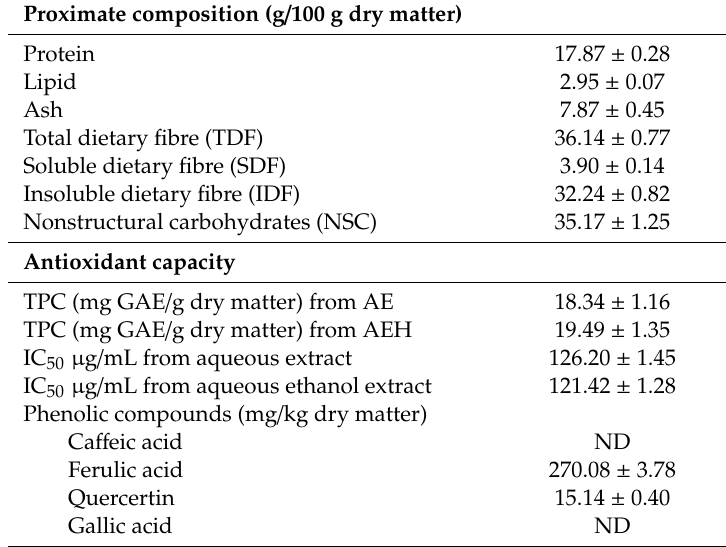
Table 2. Proximate composition, total phenolic content (TPC), IC 50 ( µ g / mL) and phenolic compounds of Moringa flower (mean values ± error standard of six